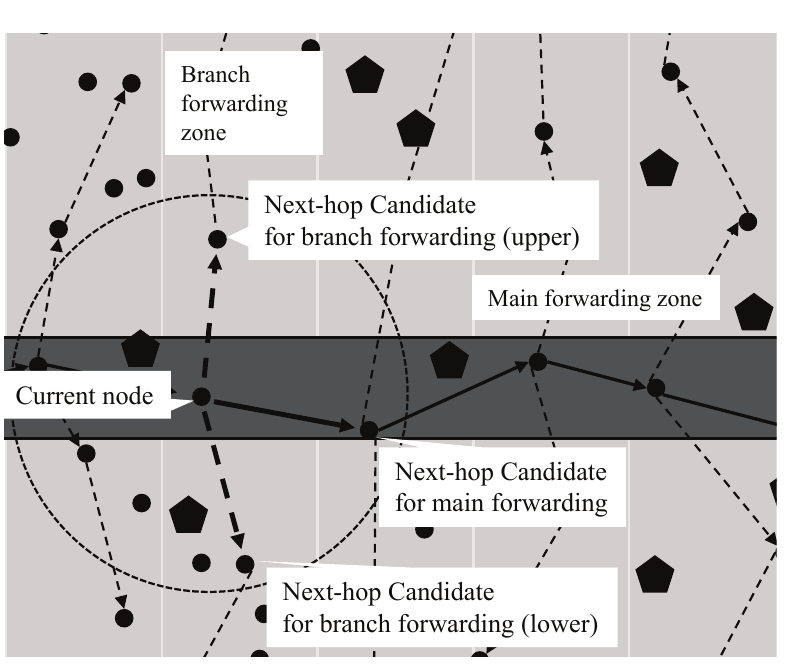
Figure 4. Real-time scheduling in branch